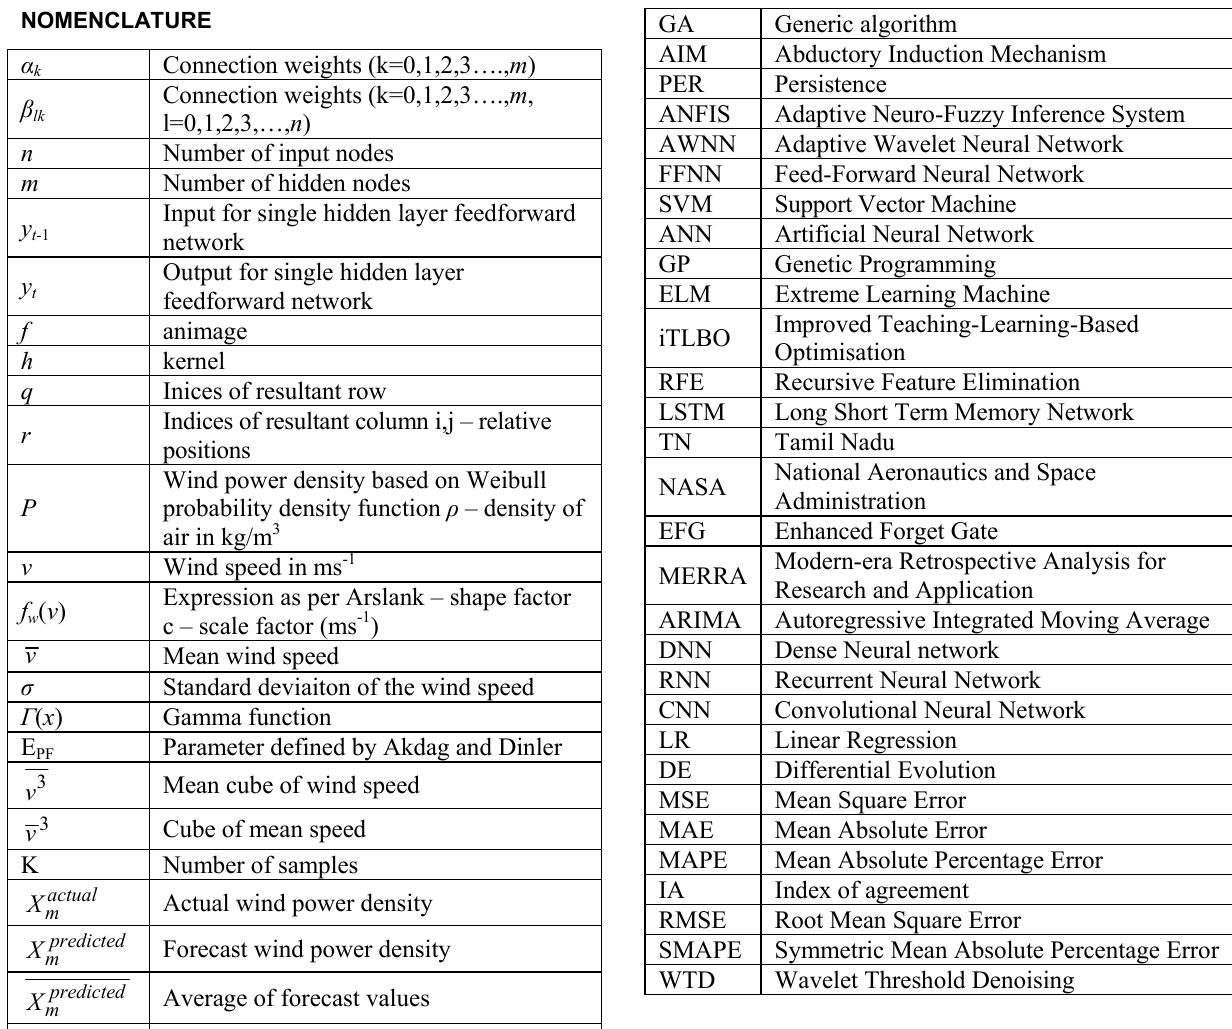
Figure 7. Prediction plot of wind speed data of various model in Tirunelveli Dataset from Jan 2018 to June